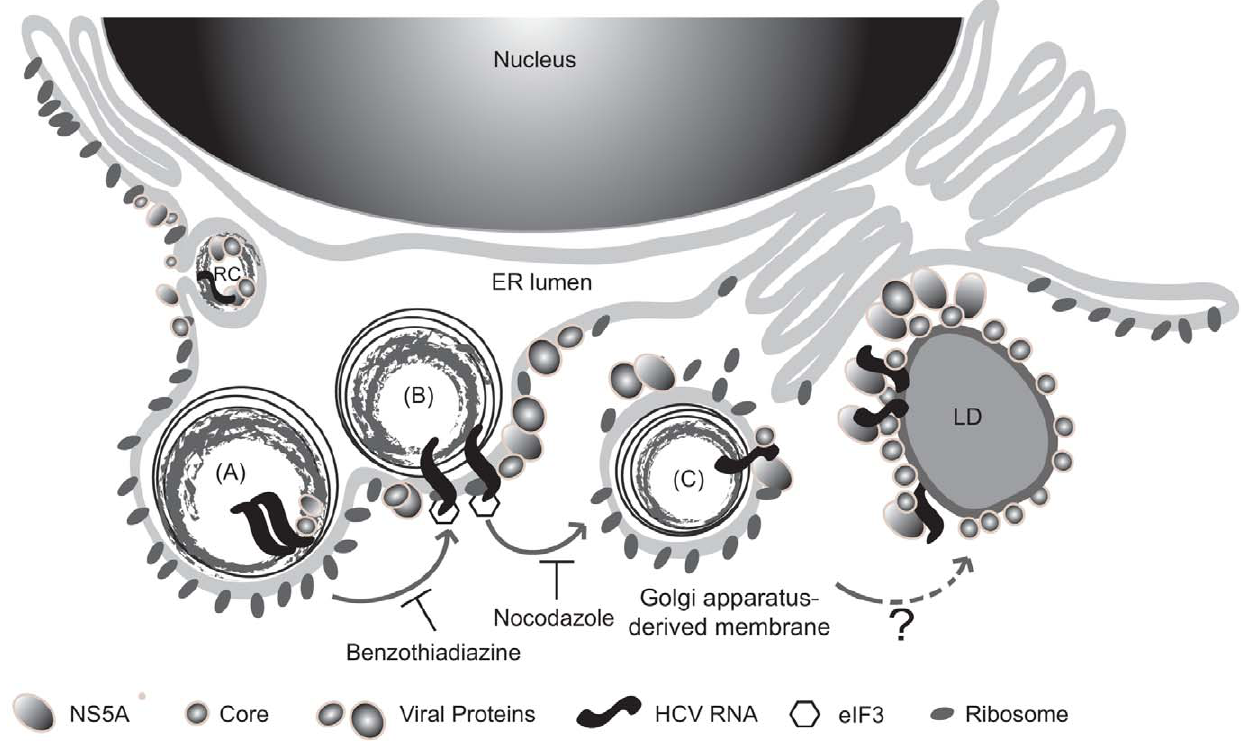
Figure 5. The proposed model of coupled replication/translation of HCV RNA. A proposed model of HCV replication-translation complex ‘‘replicasome’’. As reported, HCV replication complexes are assembled at ER, and then bud into the ER lumen. Consequently, (A) HCV RNA replication is first initiated in the multi-layered vesicle structure derived from the ER membrane. (B) The newly synthesized HCV RNA is translated around the ER- derived vesicle [39], where there are membrane-associated ribosomes. Benzothiadiazine blocks HCV RNA transcription and therefore decreases translation. (C) The newly-synthesized HCV RNA is later transported away from ER; nocodazole inhibits this transportation. HCV RNA is then transported to Golgi-derived membrane and/or then the lipid droplet (LD) for packaging and assembly of virus